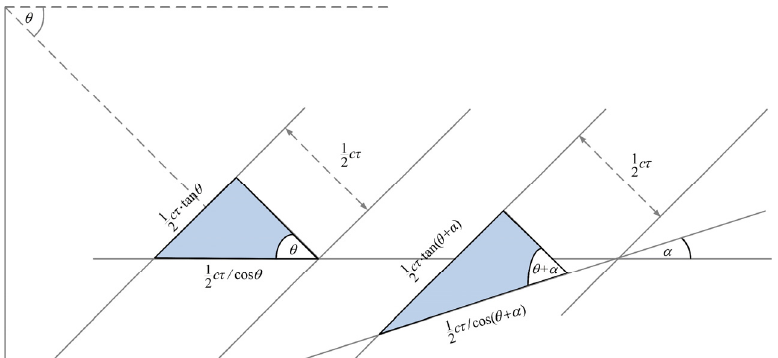
Figure 3. Angle-based radiometric terrain correction principle: The left triangle is the flat terrain and the right triangle is the steep slope (the angle is α ). The incidence angle θ i equals 90° − θ . The range resolution is 1 / 2 c τ (where c is the speed of light, and τ is the pulse duration).